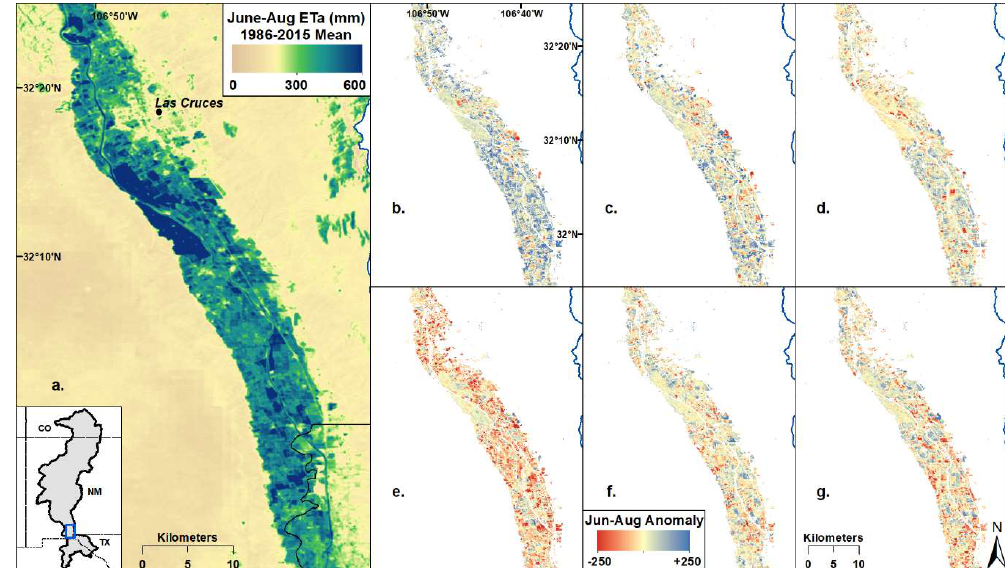
Figure 7. New Mexico June–August ETa showing ( a ) 1986–2015 mean ETa (mm), and the annual anomaly (deviation from the mean, mm) on a 5-year interval for ( b ) 1990, ( c ) 1995, ( d ) 2000, ( e ) 2005, ( f ) 2010, and ( g ) 2015.